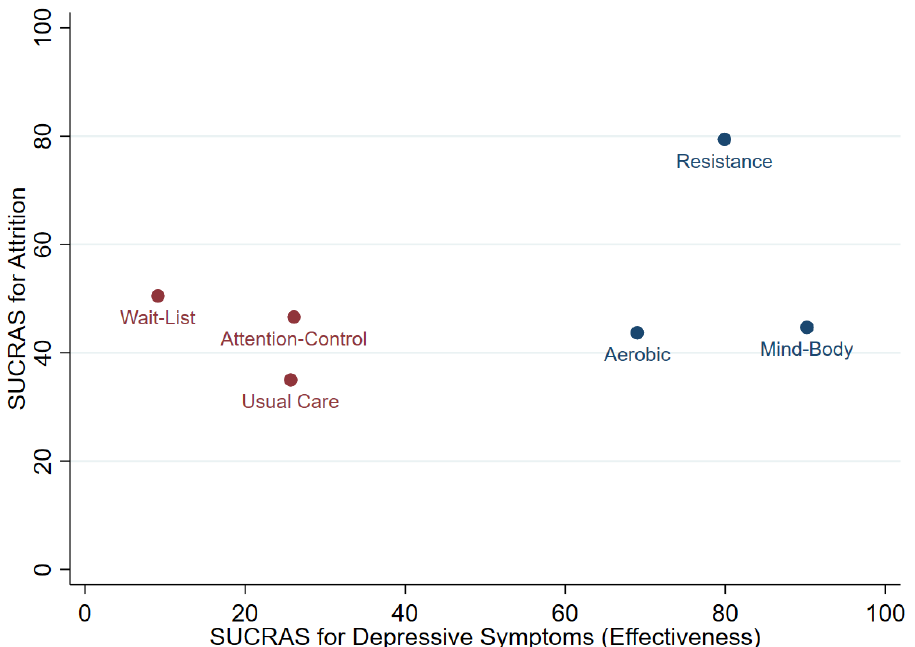
Figure 6. Clustered ranking plot of the network presenting clustered analysis of SUCRA values for depressive symptoms (effectiveness) and attrition outcomes. Each colour represents a group of treatments that belong to the same cluster. Treatments in the upper right corner represent effective treatments with low